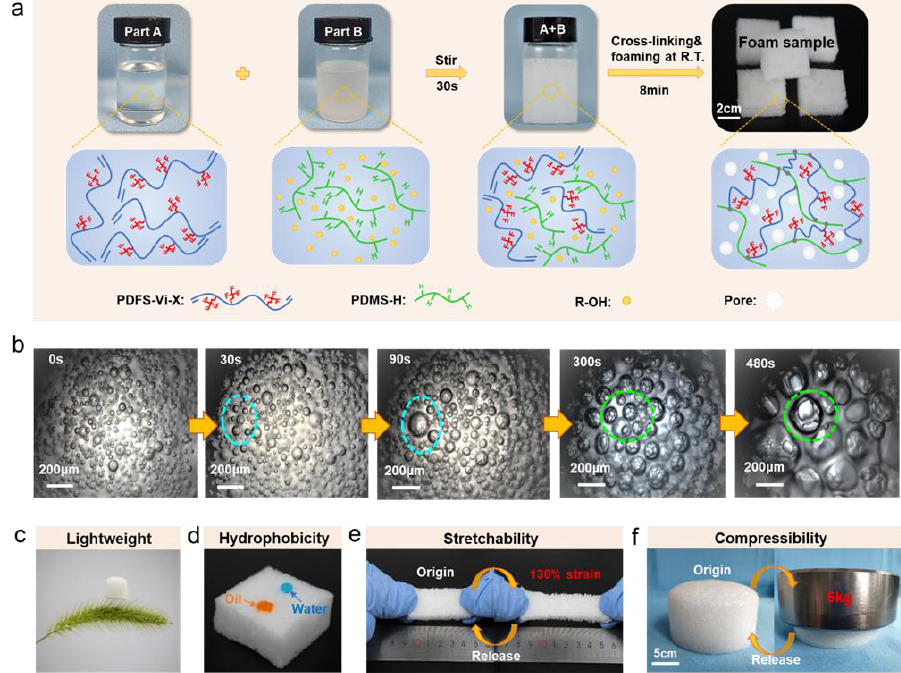
Figure 1. ( a ) Schematic illustration of the fabrication process of FSiRF materials. ( b ) Optical microscopy image of PDFS-Vi-X/PDMS-H mixture before and during foaming process. ( c ) Typical image of FSiRF sample on a foxtail grass without bending any hairy branches, indicating a lightweight nature of FSiRF materials. ( d ) FSiRF materials with a drop of water (blue color) and oil (orange color) on the surface, showing strong oleophilicity and high hydrophobicity of the surface. Digital images of FSiRF materials under ( e ) a stretching and releasing cycle and ( f ) a compressing and releasing cycle, showing good reversible stretchability and compressibility.